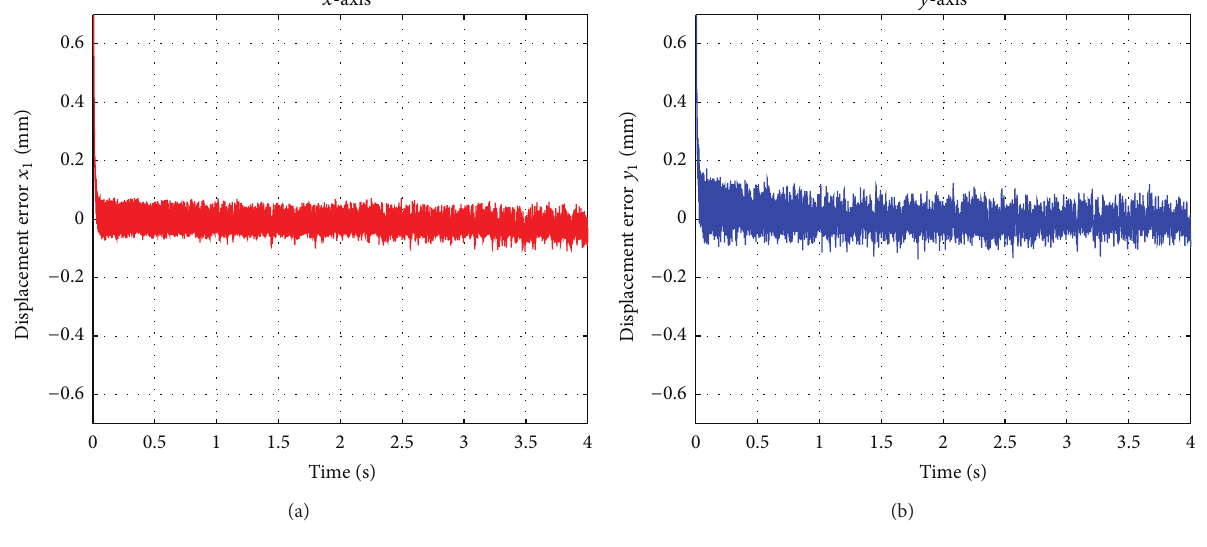
Figure 21: Rotor displacement of an AMB system with 𝑥 - and 𝑦 -axes.